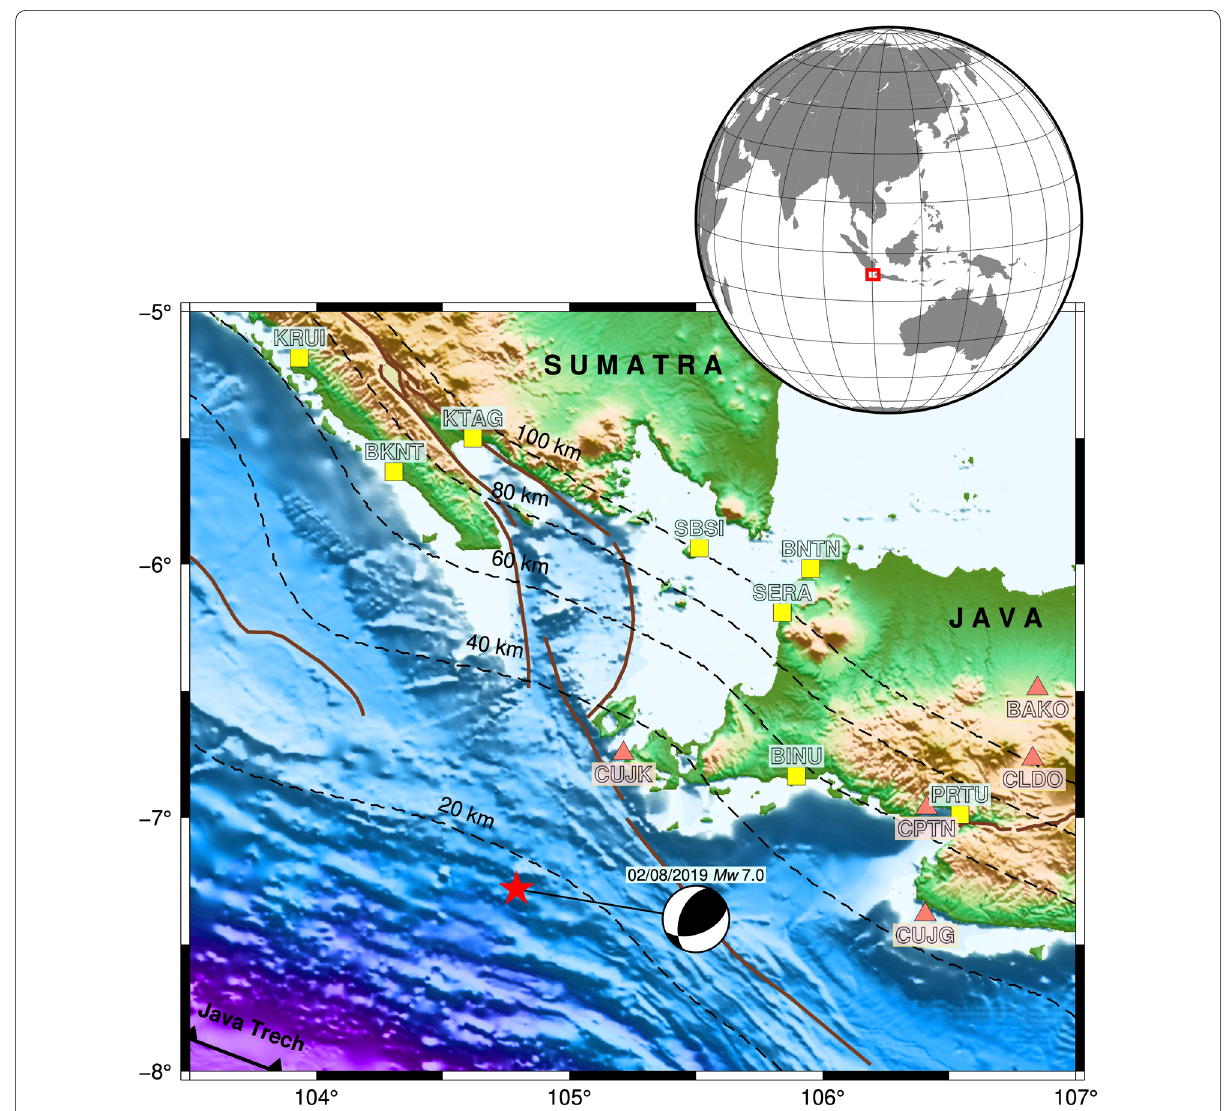
Fig. 1 Tectonic setting of this study. The red star indicates the location of the 2019 Banten earthquake, with focal mechanism from USGS. The light red colour triangles show the locations of GNSS stations, while the yellow squares indicate the location of the tide gauge. Dashed lines denote depth of slab. Brown lines remarks active faults obtained from Gunawan (2021). Bathymetry and topography are taken from SRTM15 2019). The inset shows the larger regional